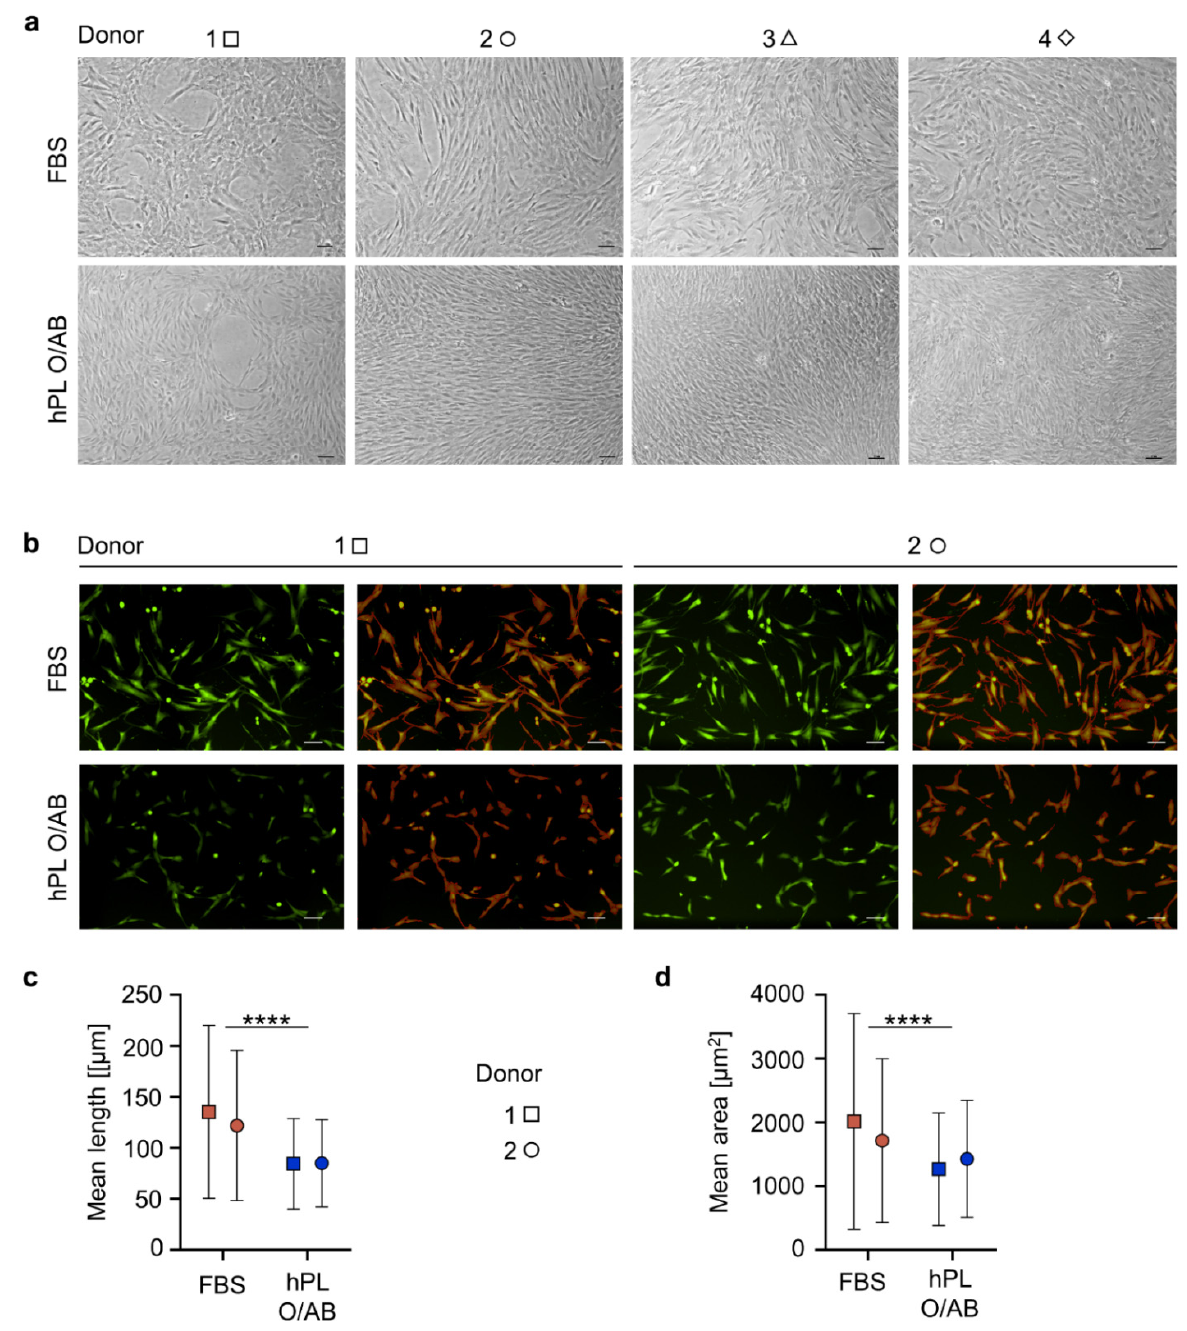
Figure A2. Large-scale propagation of BMSCs. ( a ) Representative cell morphology of BMSCs from four donors grown in 4-layered cell factories (CF4) with either FBS or hPL O/AB. Bright field, scale bar 100 µ m ( b ) Representative pictures of calcein-stained BMSCs (green) and corresponding cell segmentation (red pseudocolor) from two donors as indicated, cultured with either FBS or hPL O/AB for 24 h at passage 1. Scale bar 100 µm ( c ) Mean length and ( d ) area of BMSCs cultured as shown in ( b ); cells analyzed for donor 1—FBS, n = 1428, hPL O/AB n = 1208; donor 2—FBS n = 1343, hPL O/AB n = 1253). Kruskal–Wallis nonparametric test (**** p < 0.0001).